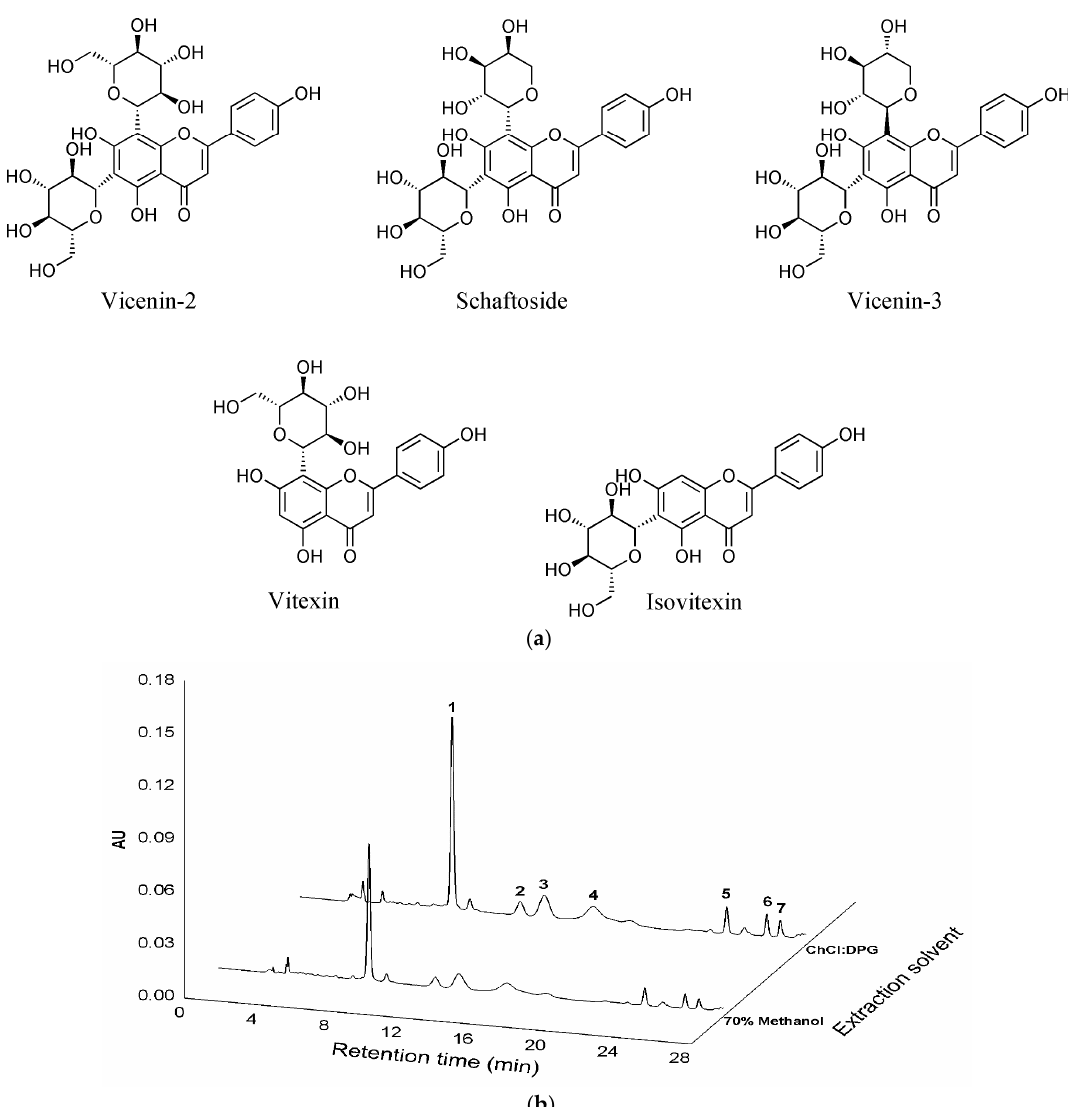
Figure 1. Chemical structures of the flavone C -glycosides in C . kanran identified in this study ( a ) and chromatograms of the C . kanran extracts ( b ). Peak identification: 1, vicenin-2; 2, vicenin-2 isomer; 3, schaftoside isomer; 4, schaftoside; 5, vicenin-3; 6, vitexin; 7, isovitexin.